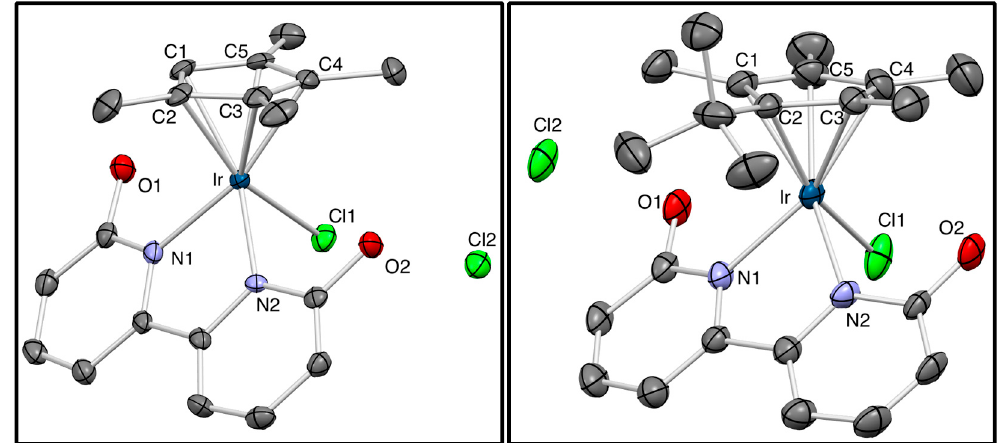
Figure 1. ORTEP illustrations of complexes 2a (left) and 2e (right) at the 50% probability level: Solvent molecules and hydrogen atoms are omitted for clarity.